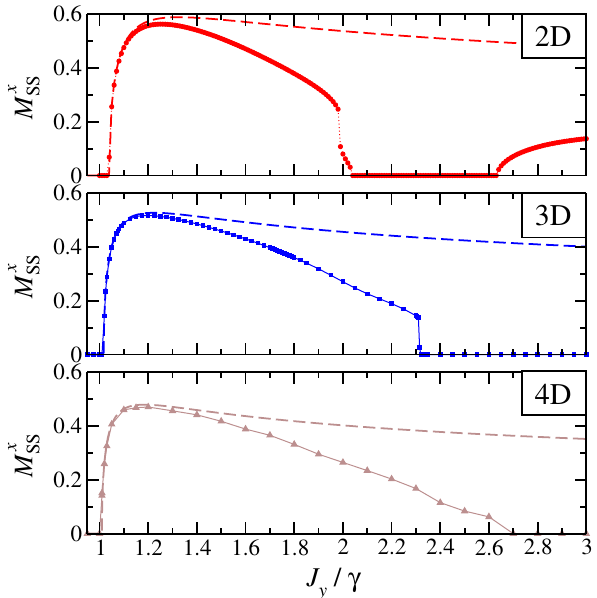
FIG. 14. Cluster mean-field analysis of the ferromagnetic order parameter for a system defined on a square lattice geometry in different dimensionalities. The upper panel refers to 2D ( z ¼ 4 ), the middle one to 3D ( z ¼ 6 ), and the lower one to 4D ( z ¼ 8 ). Dashed lines denote the MF predictions, while symbols and continuous curves are the results of numerical simulations, with clusters of size L ¼ 2 D ( D being the system dimensionality).